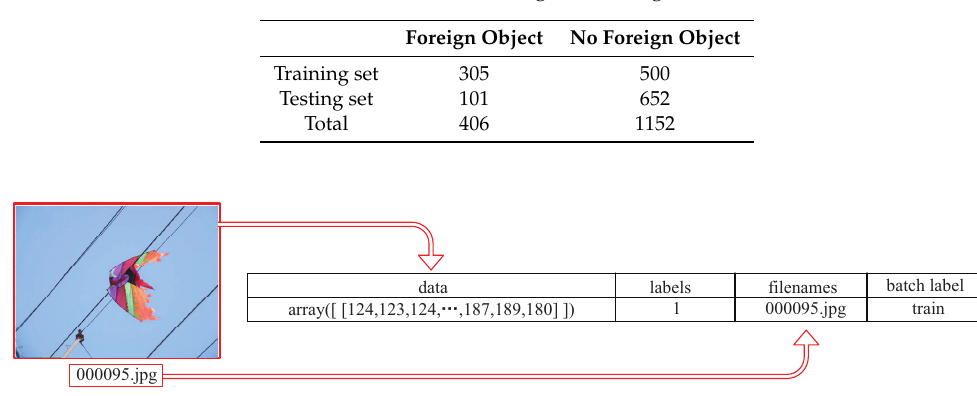
Table 1. Division of training and testing dataset.